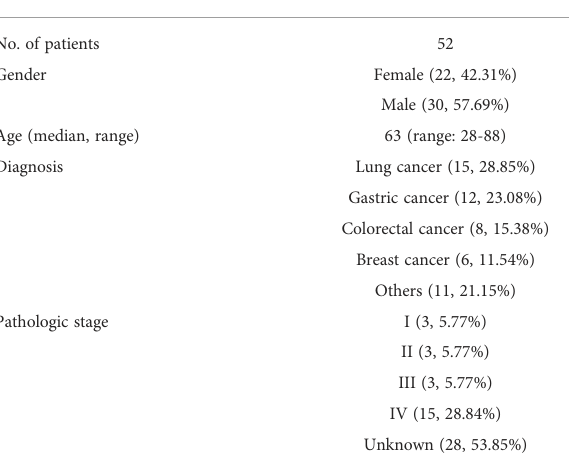
TABLE 3 A summary of ERBB2-KD fusion tumor patients ’ demographic and clinical characteristics in Chinese cohort.